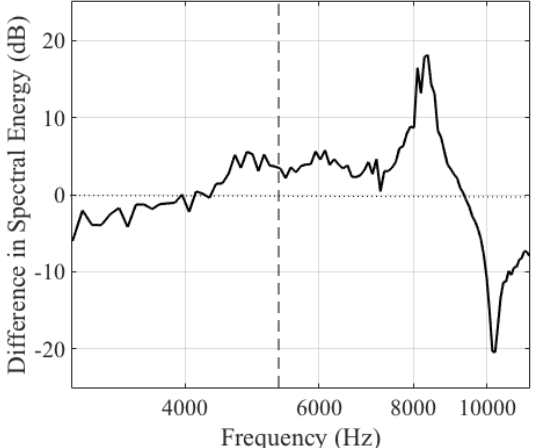
Figure 4. Di ff erence in ear-input spectral energy of the height layer to the main layer of a vertical quadraphonic configuration. The vertical dashed line separates the frequency range for the 4 kHz octave band (left) from that for the 8 kHz octave band (right).